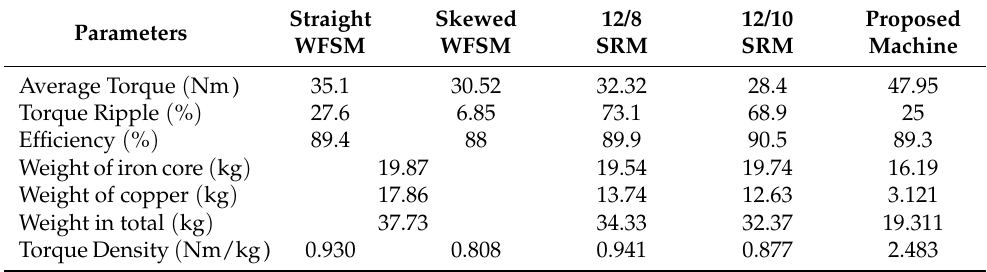
Table 5. Performance comparison of conventional and proposed design.